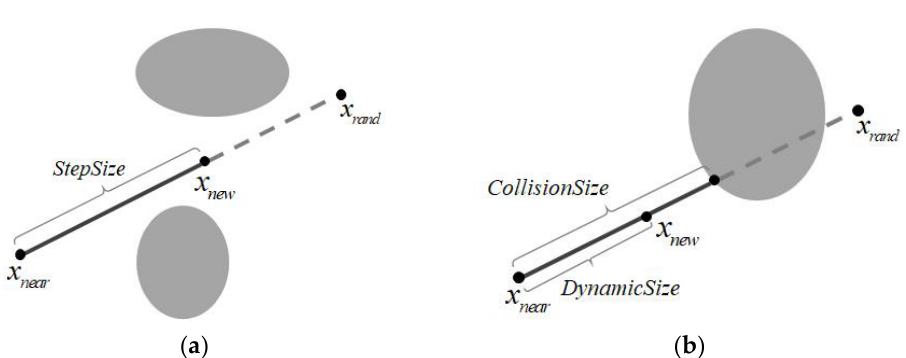
Figure 8. Comparison of fixed step size and dynamic step size. ( a ) Fixed step size; ( b ) dynamic step size.